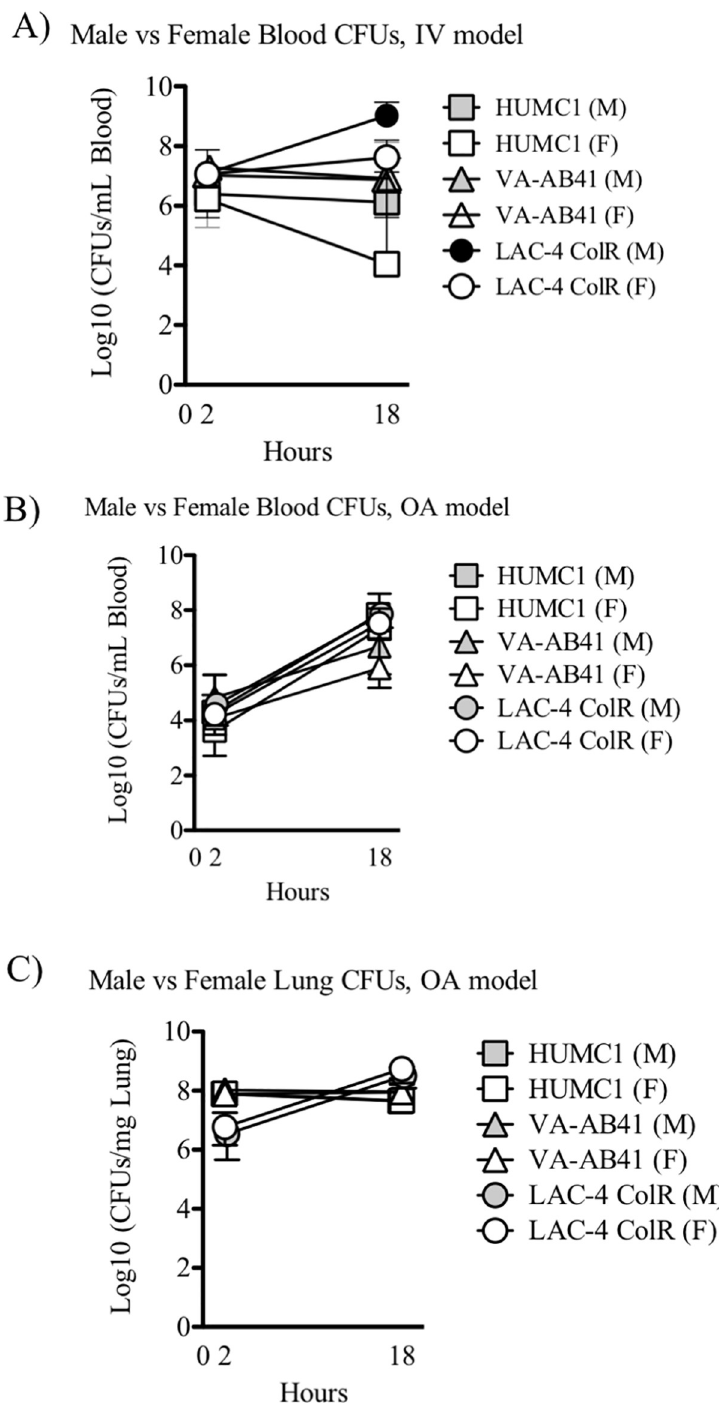
Fig 3. Blood and lung bacterial densities in male and female mice infected with A . baumannii strains. Male and female C3H/FeJ mice were challenged with A . baumannii strains HUMC1, VA-AB41, or LAC-4 Col R . A) Mice were infected IV with > LD100s for each strain: HUMC1 (2.0x10 7 CFU), VA-AB41 (2.7x10 7 CFU), LAC-4 Col R (9.7x10 7 CFU). Blood was collected at 2 and 18 hours and serial dilutions were plated to determine the bacterial burden. No significant difference was observed between gender. At 2 hours, a significant difference was observed between HUMC1 vs VA-AB41 and LAC-4 Col R infected mice (P < .01). At 18 hours, a significant difference was observed between HUMC1 and LAC-4 Col R infected mice (P < .01). B) Mice were challenged via the lung with > LD100s for each strain: